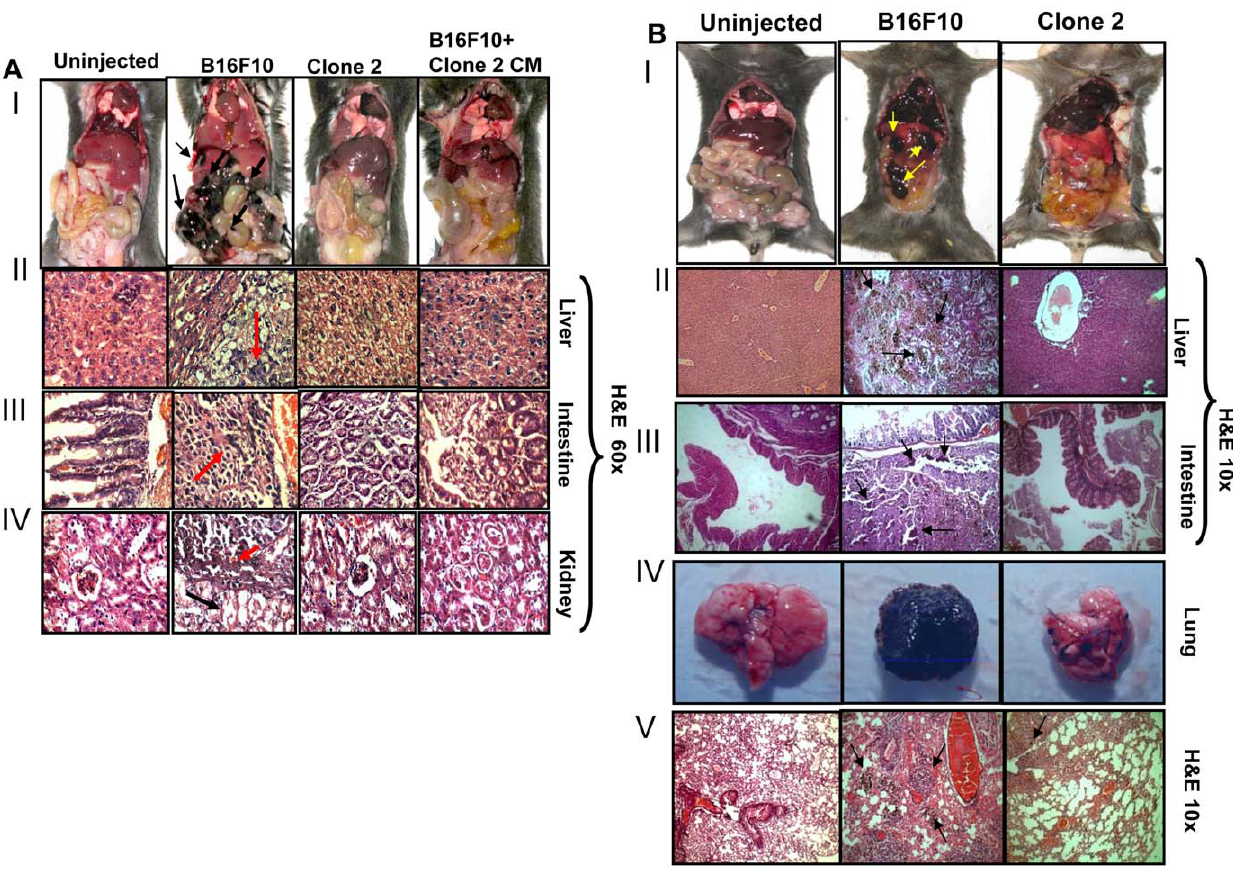
Figure 7. Sema 3A overexpression attenuates melanoma metastasis. ( A ) The mice described in Fig. 6A, were dissected ventrally and photographed. Growth of melanoma tumors were indicated by arrows (Fig. 7A, panel I). Internal organs (liver, intestine and kidney) were analyzed histopathologically and the micrographs were shown at 60 6 magnification (Fig. 7A, panels II–IV). Melanoma positive cells in metastatic lesions were marked by red arrows, whereas surrounding stromal regions were indicated by black arrows. Six mice were used in each group. Un-injected mice are used as control. ( B ) Sema 3A attenuates melanoma metastasis in mice. Control or clone 2 cells were injected intracardiaclly and mice were sacrificed, dissected ventrally and photographed (Fig. 7B, panel I). Metastasized organs were indicated by arrows. Liver and intestine of the mice were analyzed histopathologically by H&E staining (Fig. 7B, panels II & III). Micrographs were taken at 10 6 magnification. Arrows showed the melanoma foci. Fig. 7B, panel IV shows the excised lung of respective mice. Lung sections were also analyzed histopathologically and photographs were taken at 10